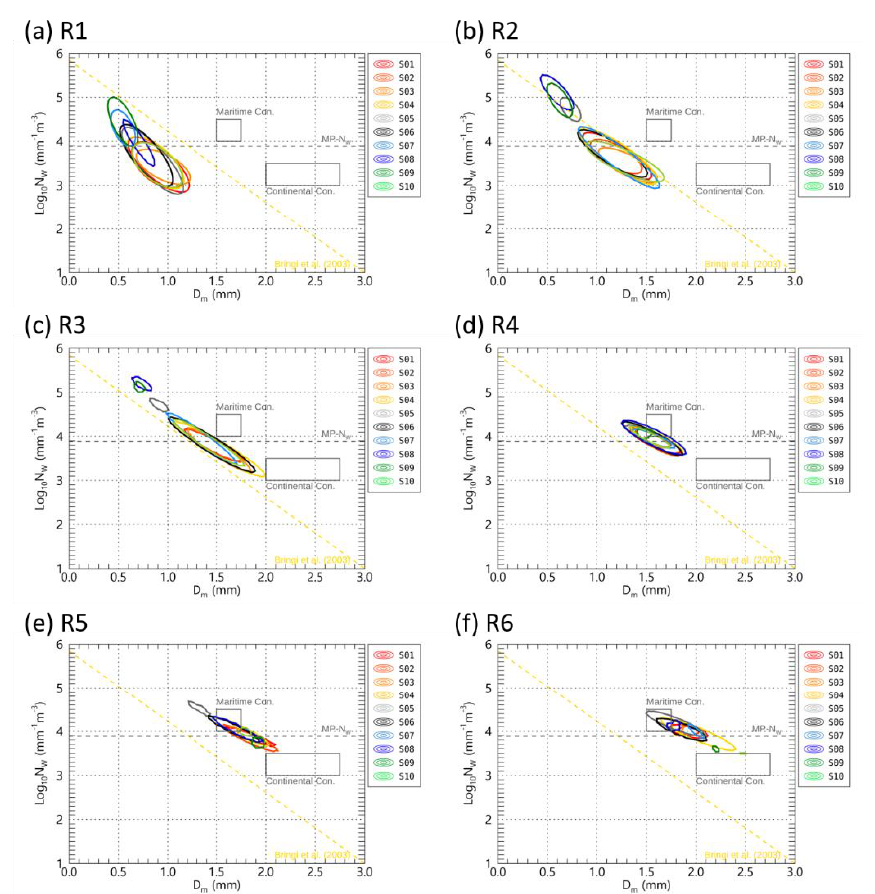
Figure 9. The Gaussian two-dimensional fitting circle with ( a , b ) 30% or ( c – f ) 20% of the normalized frequency of Nw versus Dm distribution for rain rate categories. The yellow dashed lines indicate the stratiform precipitation fitting line by Bringi et al. [14].